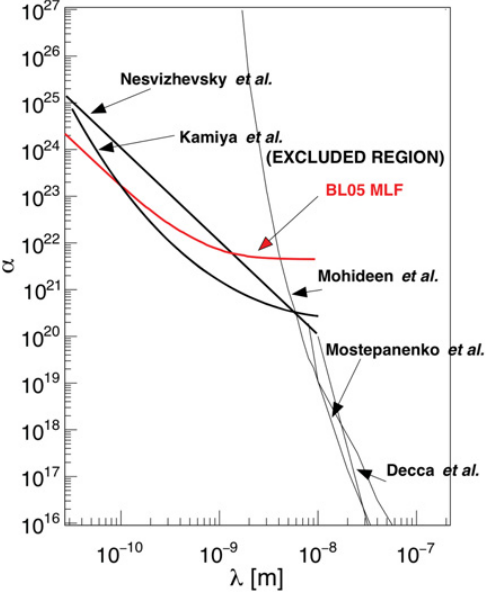
Figure 4. Constraints on Yukawa-like gravity parameter α as a function of interaction length λ by comparing measured q spectra to simulated data. Image taken from [5].